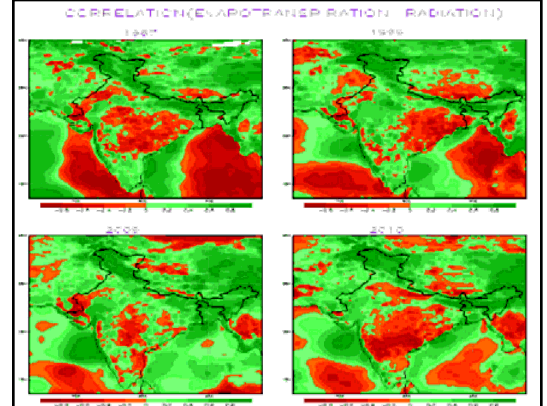
Figure 7. Correlation between evapotranspiration (mm/day) and radiation (W/m 2 ) ρ (E,R n ) using BATS scheme for El Niño (1987,2009), La Niña (1999,2010) years.